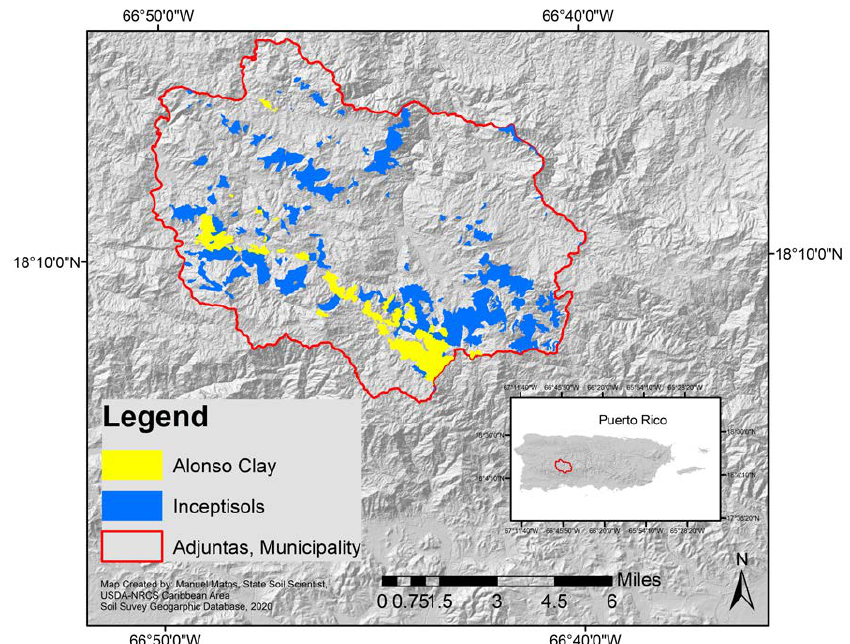
Figure 2. Experimental orchard location, and location of Inceptisols, including Alonso clay (Data